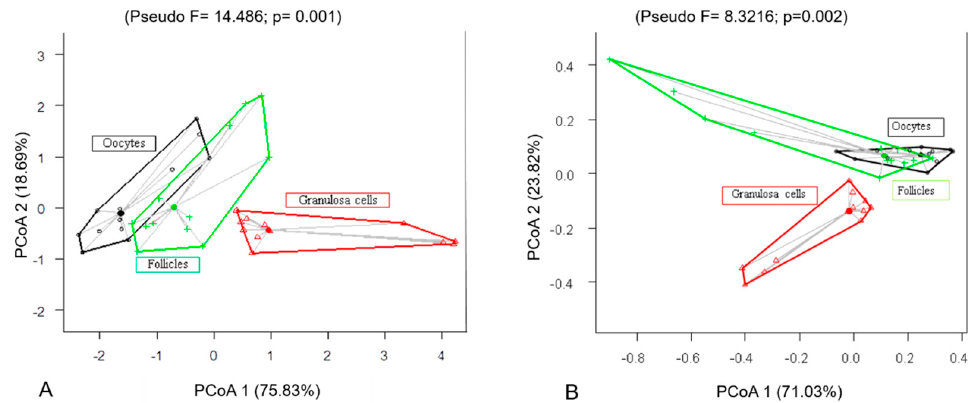
Figure 3. Principal coordinate analysis (PCoA) of the variation in the follicular cells, follicle, and